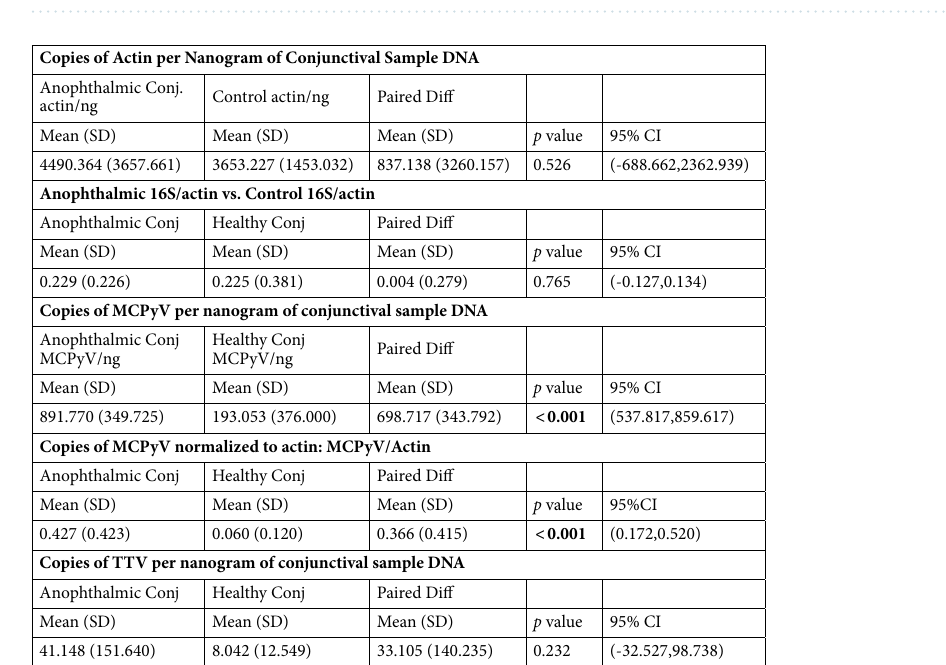
Figure 1. Quantitative (top) and qualitative PCR for 16S ribosomal DNA from anophthalmic (left) and contralateral (right) conjunctiva. Lower images are from ethidium-bromide stained gel electrophoresis. H20 = double distilled water negative control.